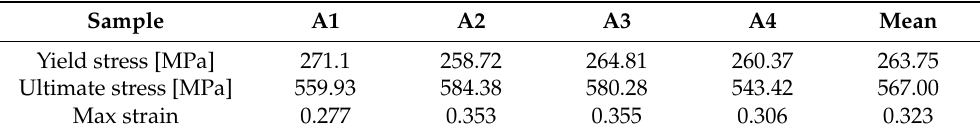
Figure 12. True stress-strain behavior from tensile tests. Table 4. Experimental result of the tensile tests.